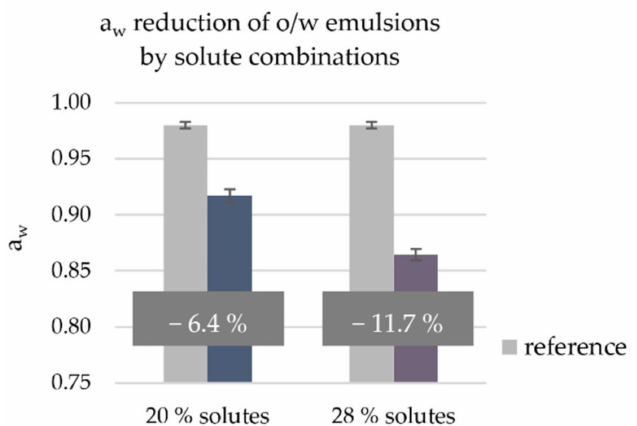
Figure 1. Mean water activities of o/w emulsions with 20% or 28% of the solute combination (colored bars) compared to the reference o/w emulsion without solutes (grey bars) at 25 ◦ C with standard deviation error bars ( n = 2) and percent reduction